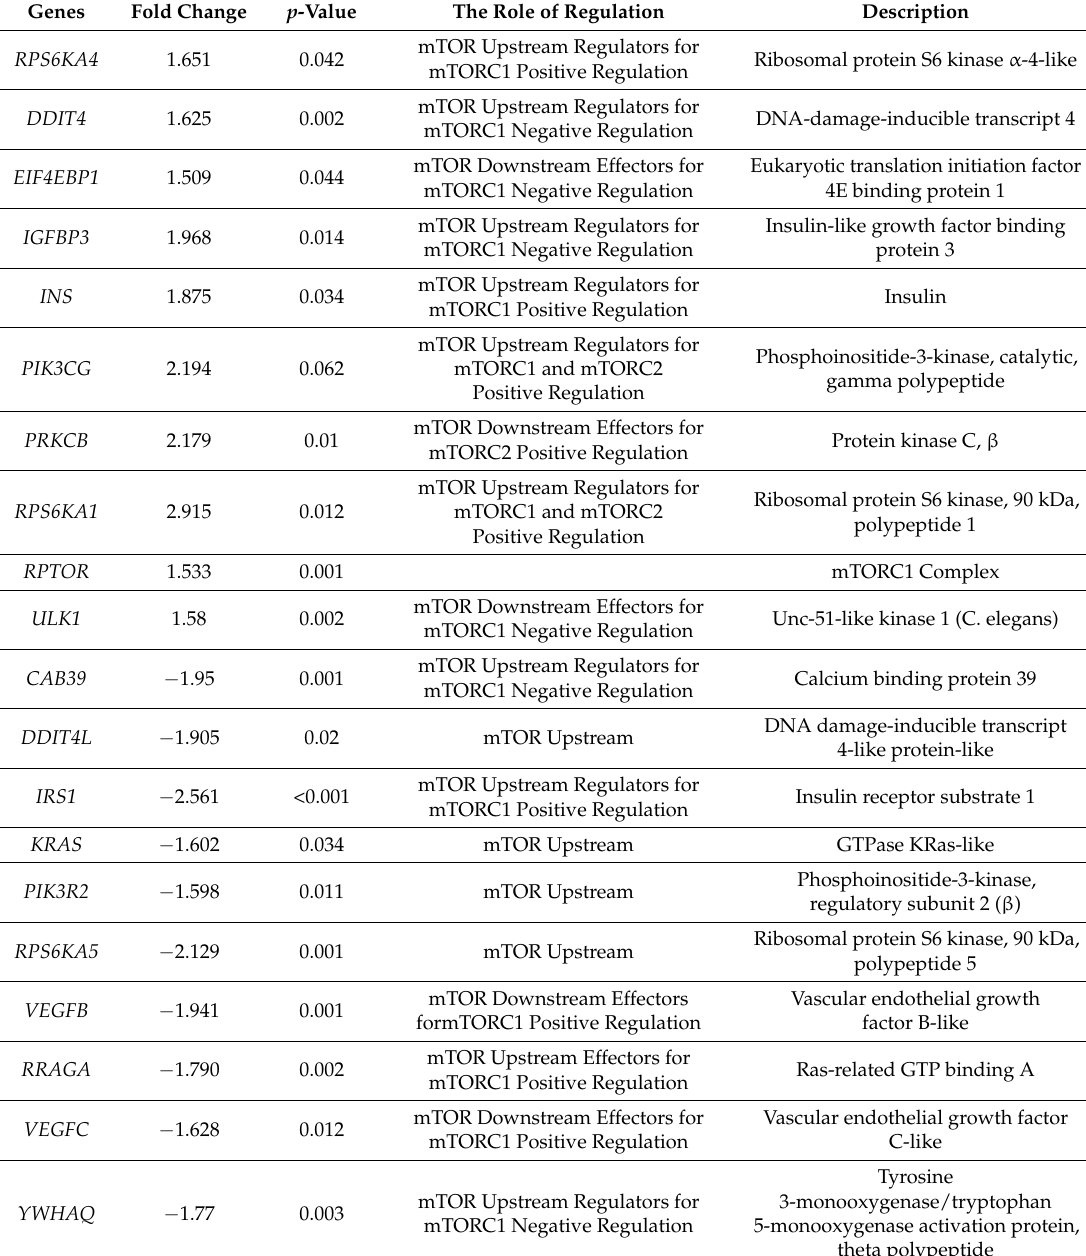
Table 2. Transcriptional expression profiles of mTOR signaling-related genes in